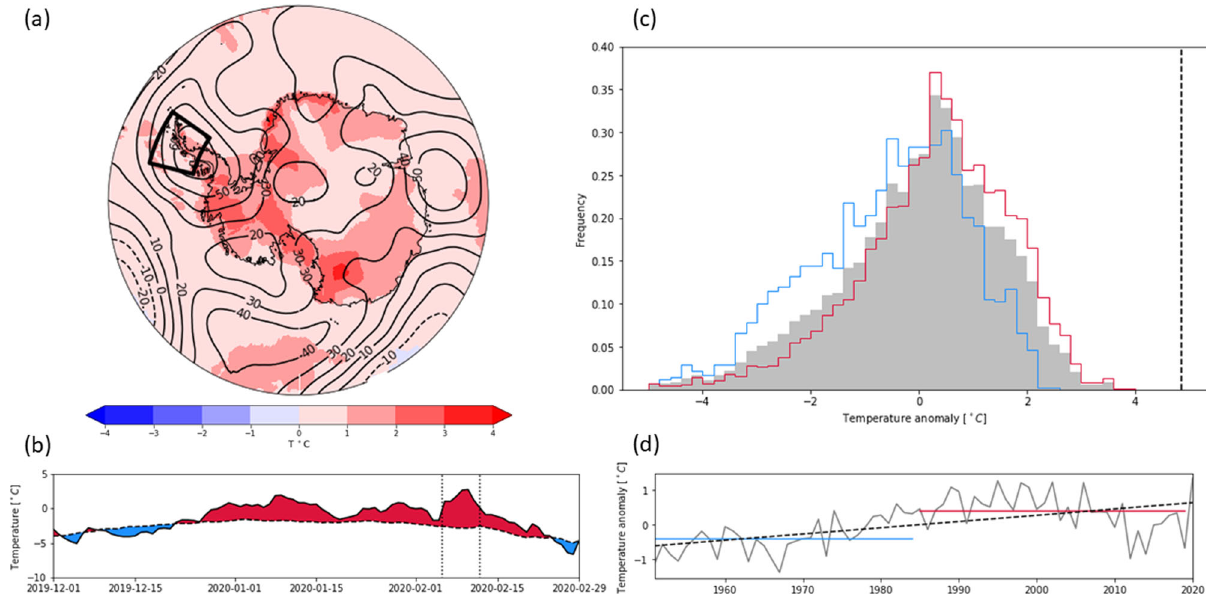
Fig. 2 Summer 2020 anomalies and climatological distribution and trends. a Z500 (contours; gpm) and T2m (shading; °C) anomalies for the 2020 summer (Dec – Feb) with the AP region highlighted. b Daily time series of regional mean AP T2m over land (in °C) for the 2020 summer (black solid line), with positive (negative) anomalies in red (blue). Dashed line shows the corresponding climatological values (1950 – 2019) and dotted vertical lines indicate the 6 – 11 Feb 2020 period. c Climatological (1950 – 2019) frequency distribution of the 6-day running mean series of AP T2m anomalies for all summer days of the 1950 – 2019 period (in °C, wrt 1950 – 2019). Blue and red lines show the corresponding distributions for the past (1950 – 1984) and recent (1985 – 2019) sub-periods, respectively. Vertical dashed line shows the 6-day mean AP T2m anomaly for 6 – 11 February 2020. d Time series of summer T2m anomalies for the AP region (°C, wrt 1950 – 2019). The dashed line indicates the linear trend. Blue and red lines show the climatological means for the past and recent sub-periods. Data source: ERA5